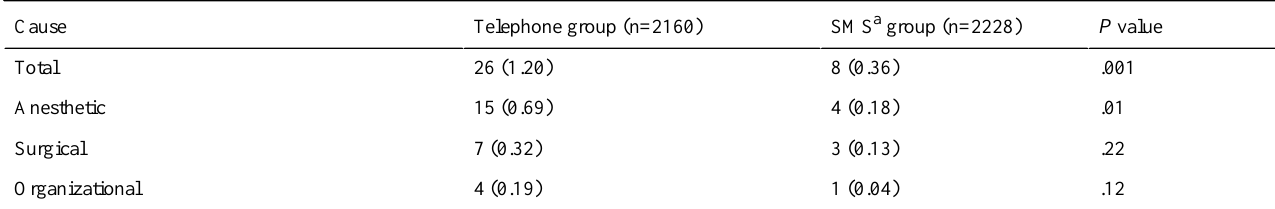
Table 2. Conversion rates to full-time hospitalization between groups and according to the cause of hospitalization (n=4388).